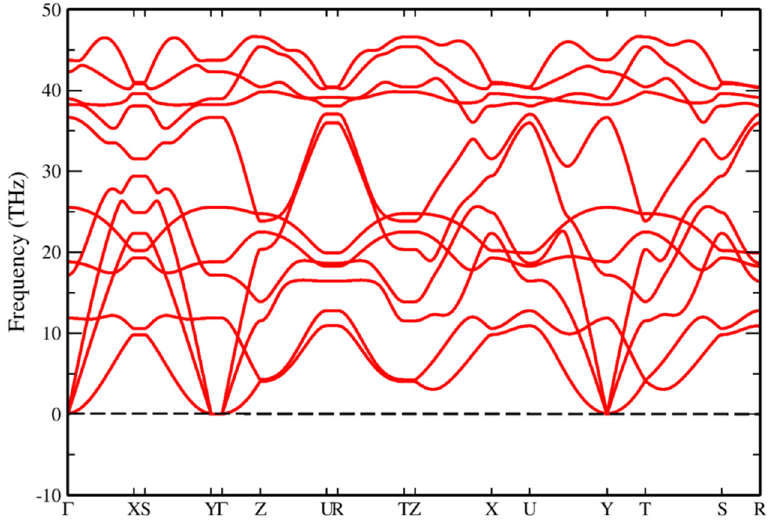
Figure 4. Phonon dispersion relation of HCBN calculated at the local density approximation (LDA) level.